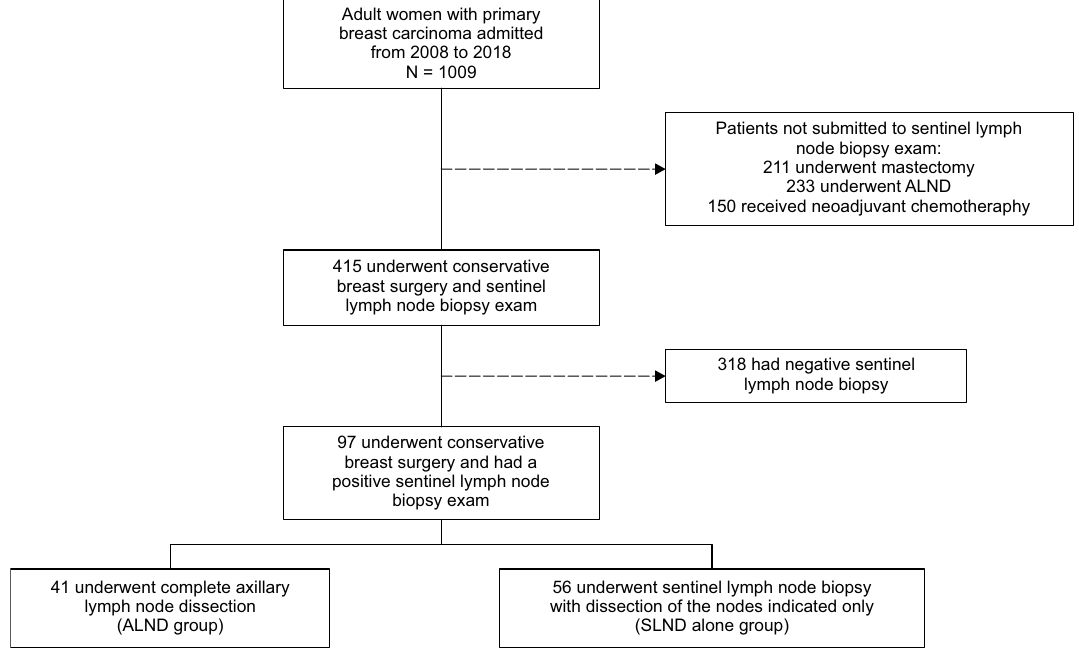
Figure 2. Flow diagram of patient inclusion procedure used in the study.